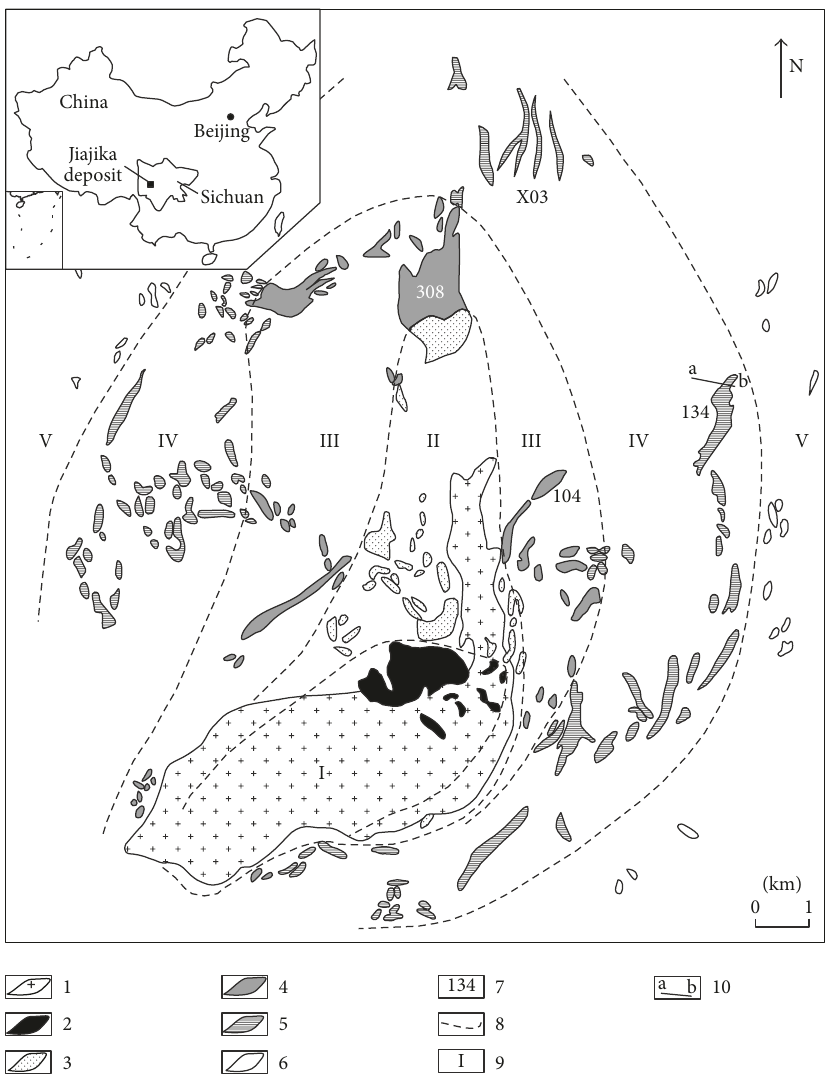
Figure 1: Distribution map of granitic pegmatites in Jiajika deposit, Sichuan Province. 1: two-mica granite; 2: microcline type pegmatite; 3: microcline-albite type pegmatite; 4: albite type pegmatite; 5: albite-spodumene type pegmatite; 6: albite-lepidolite type pegmatite; 7: number of pegmatite dikes; 8: zoning line of different type of pegmatite; 9: zoning number of different type of pegmatite: I: microcline type pegmatite zone; II: microcline-albite type pegmatite zone; III: albite type pegmatite zone; IV: spodumene type pegmatite zone; V: lepidolite (muscovite) type pegmatite zone; 10: location of the cross section of number 134 pegmatite dike shown in Figure